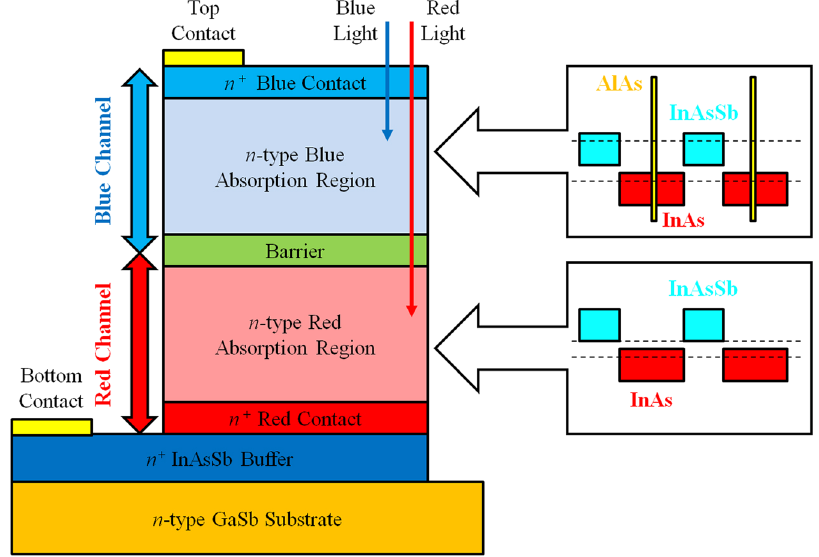
Figure 2. The schematic diagram of the bias-selectable dual-band nBn LWIR/VLWIR photodetector structure and the schematic band alignment of superlattices in both the blue and red absorption regions. The colored rectangles in the insets represent the forbidden gap of the constituent layers. The dashed lines represent the effective bandgaps of the